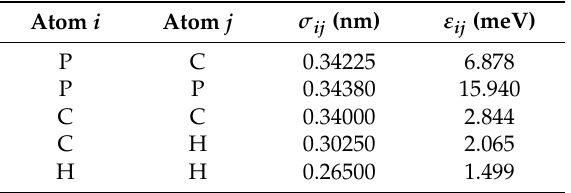
Table 7. The L–J potential parameters among carbon, hydrogen, and phosphorus atoms. Atom i Atom